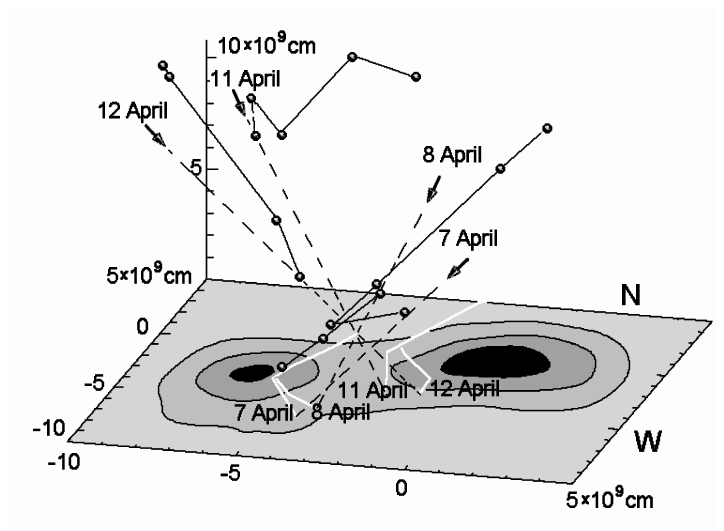
Fig. 3. Spatial distribution of the coronal magnetic (cid:12)eld for the active region NOAA 9415. Dots present the induction of B = 21 G. Arrows show the directions of observa- tions day-by-day. White lines are projections of isogaussian lines of B = 21 G onto the